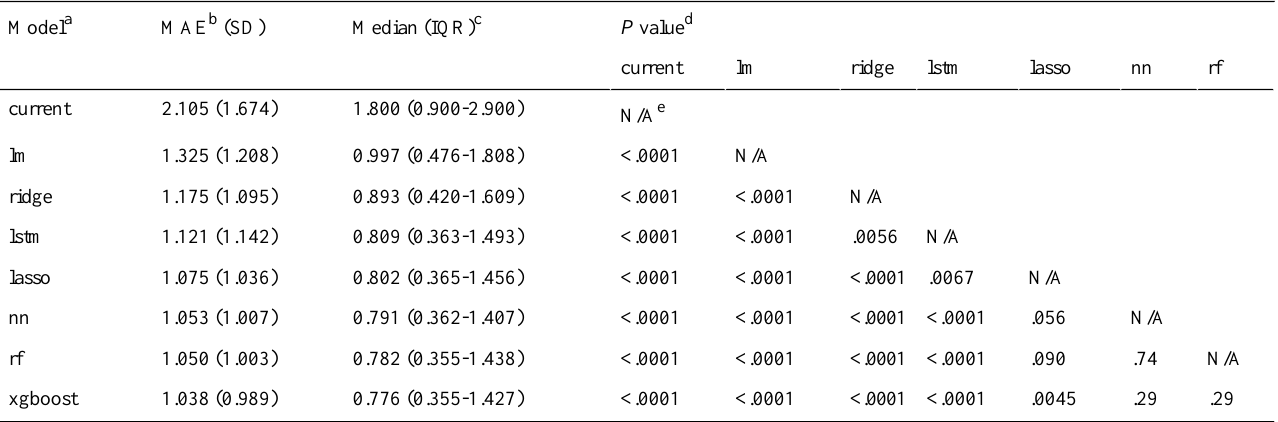
Table 1. Pairwise comparison of the predictive